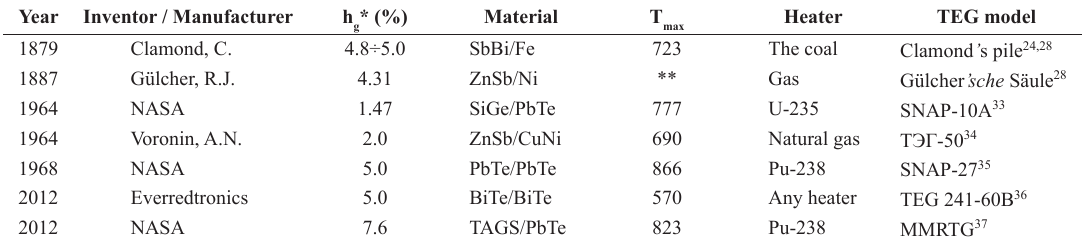
Table 2. Characteristics of TEGs taken from reliable sources. Year Inventor /